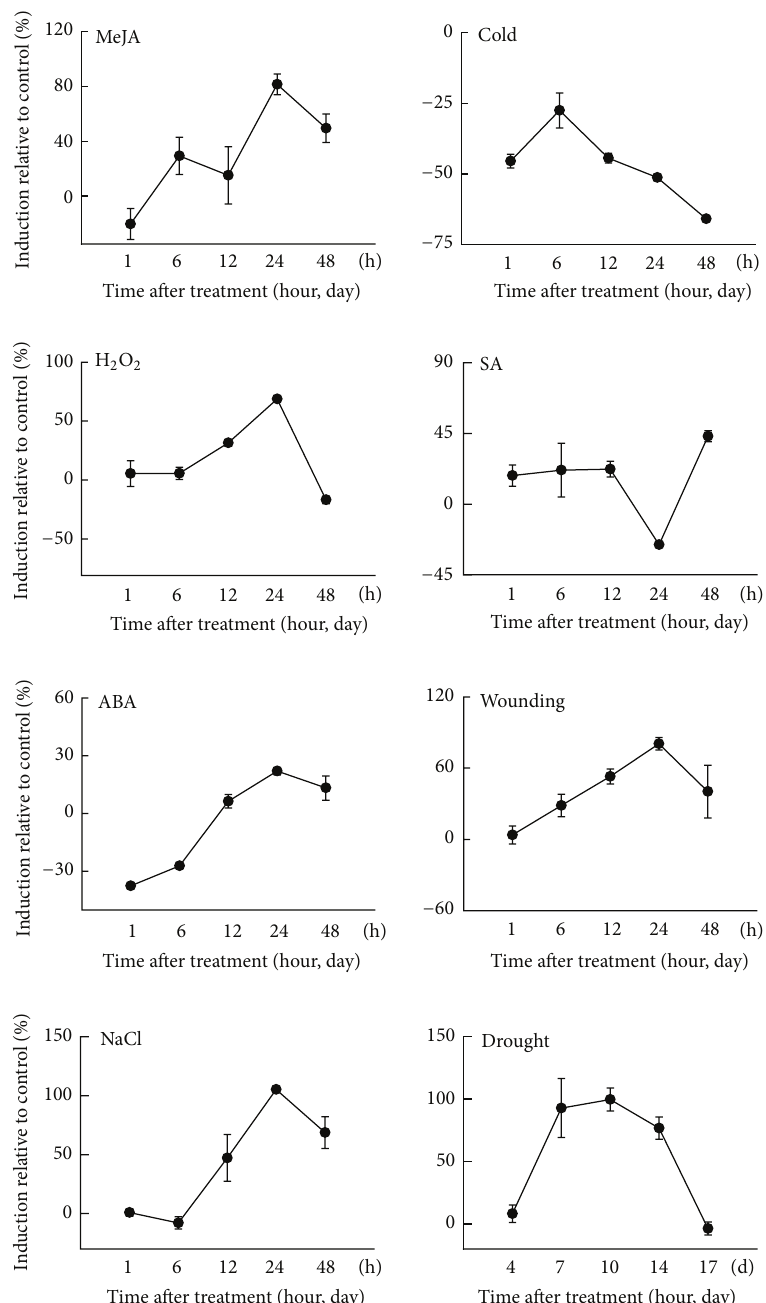
Figure 6: Transcript expression patterns of HcCCR2 in response to various abiotic stresses. Three-week-old stem tissues were treated with different stresses such as wounding, salicylic acid (SA), NaCl, cold, H 2 O 2 , methyl jasmonate (MeJA), abscisic acid (ABA), and drought. Bars show means ± standard error of 3 biological